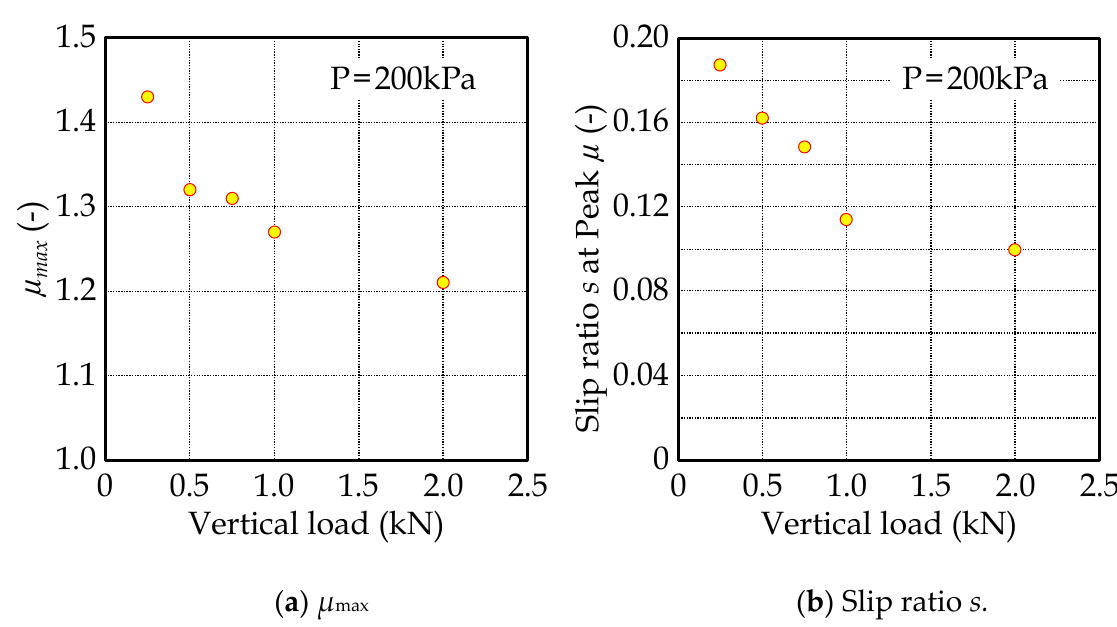
Figure 11. Characteristics of measurement tires against load changes.